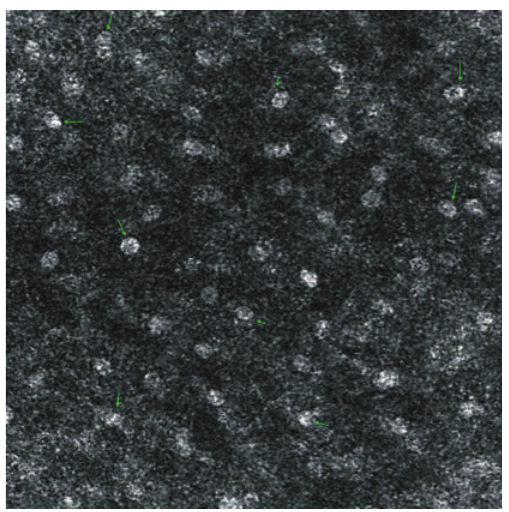
Figure 6: Reflectance confocal microscopy image at the stratum granulosum layer (Z1). Green arrows: nuclei display mostly as bright rounded structures and a fine granular apperance of the cytoplasm is observed.